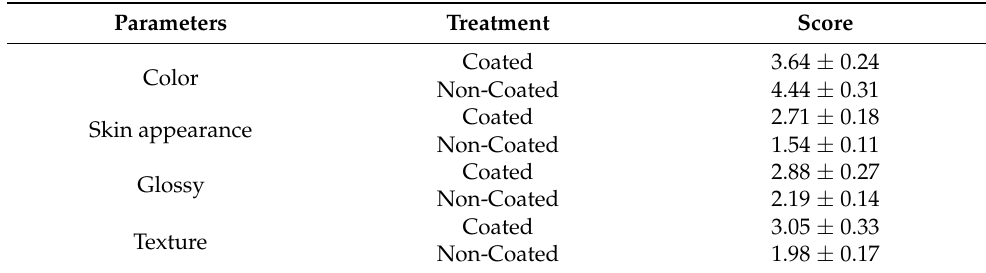
Table 2. Organoleptic properties of tomato stored for 9